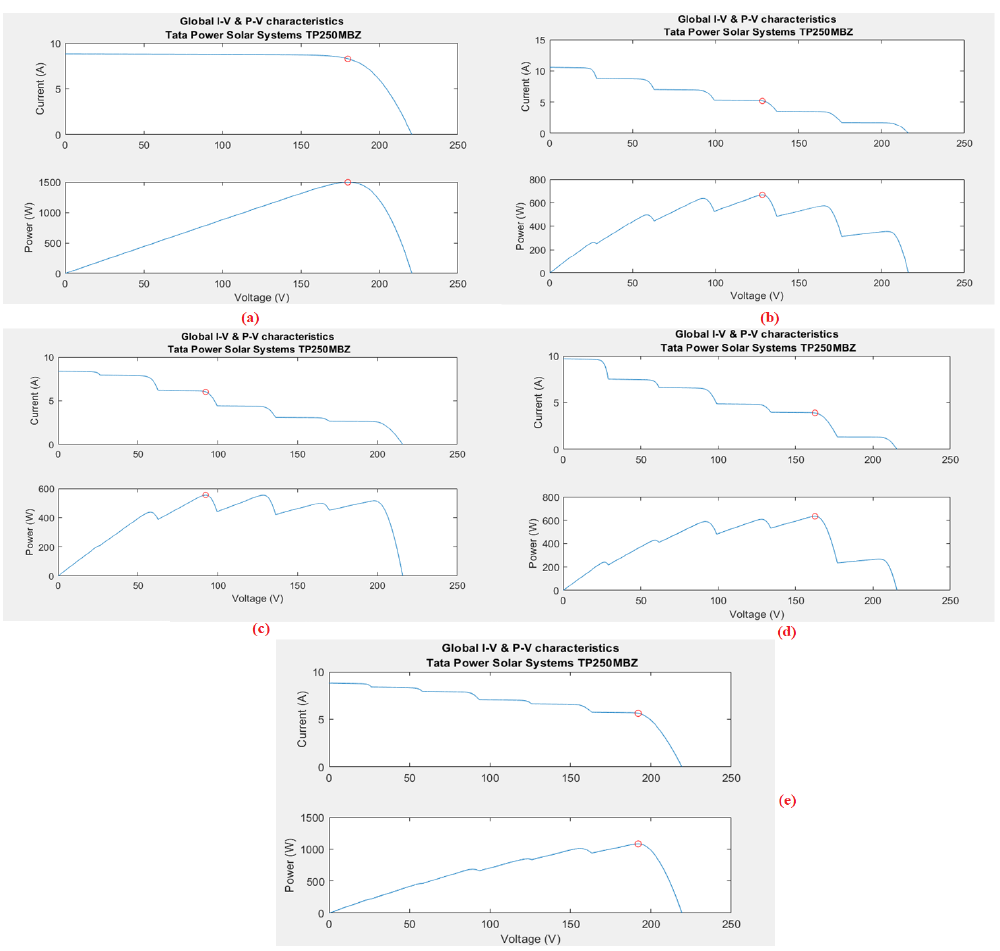
Figure 12. The current – voltage (I - V), and power – voltage (P - V) characteristic curves under different shading conditions. ( a ) For the UIC graph; ( b ) For the second CPSC graph; ( c ) For the third CPSC graph; ( d ) For the fourth CPSC graph; ( e ) For the fifth CPSC graph.